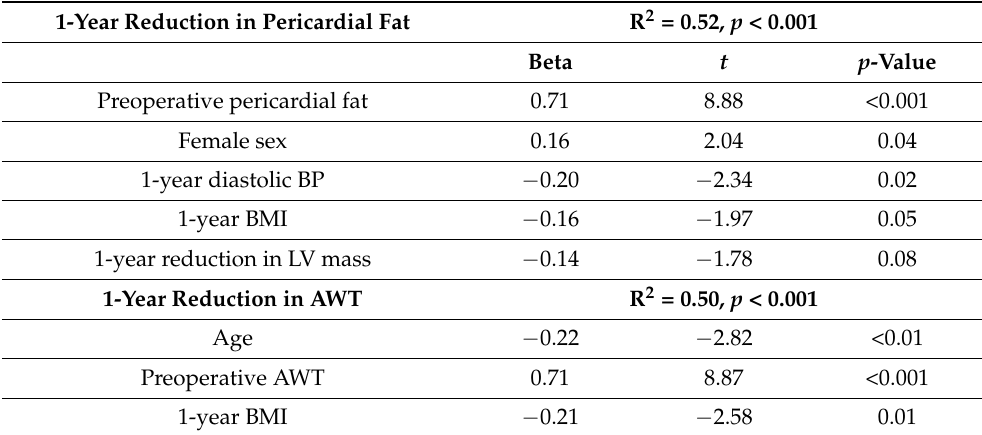
Table 2. Predictors of reduction in pericardial fat and AWT 1 year after bariatric surgery identified in multivariate linear regression analysis run with backward stepwise removal of non-significant variables. Excluded variables in both models: age; preoperative diabetes, systolic and diastolic BP, BMI and AWT; 1-year systolic BP and 1-year reduction in heart rate. 1-Year Reduction in Pericardial